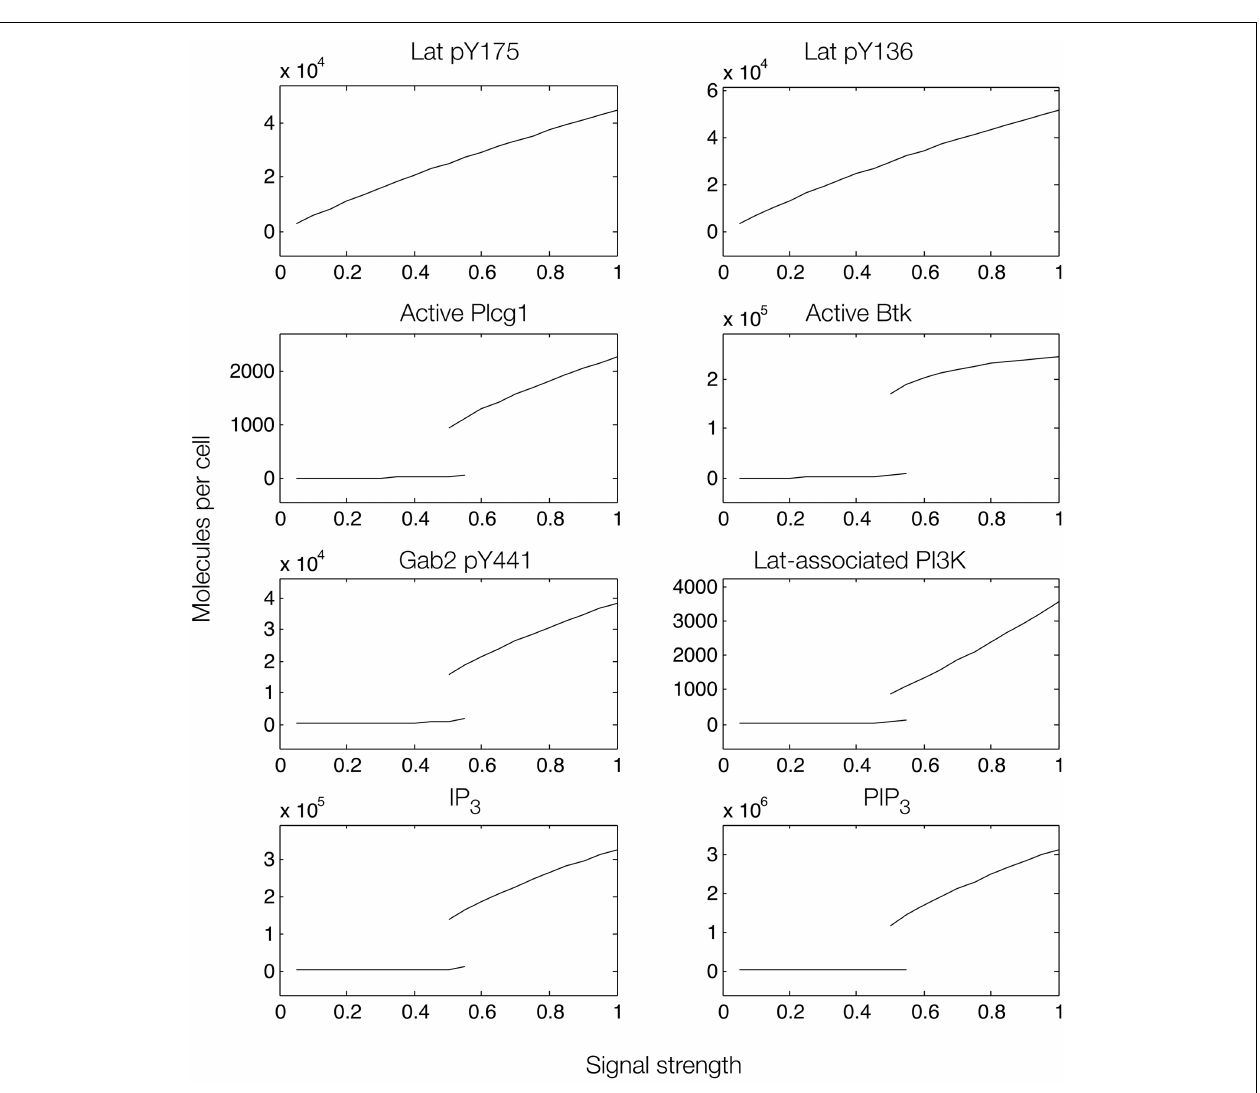
FIGURE 8 | Steady-state dose–response curves, which were found by simulation of the feed-forward loop connecting Lat to IP 3 production when Gab2-mediated positive feedback is considered . Each plot is a bifurcation diagram; the bifurcation parameter is signal strength, which governs the rate of production of active Syk and Fyn. Only stable steady states are shown. As can be seen, the model predicts the possibility of